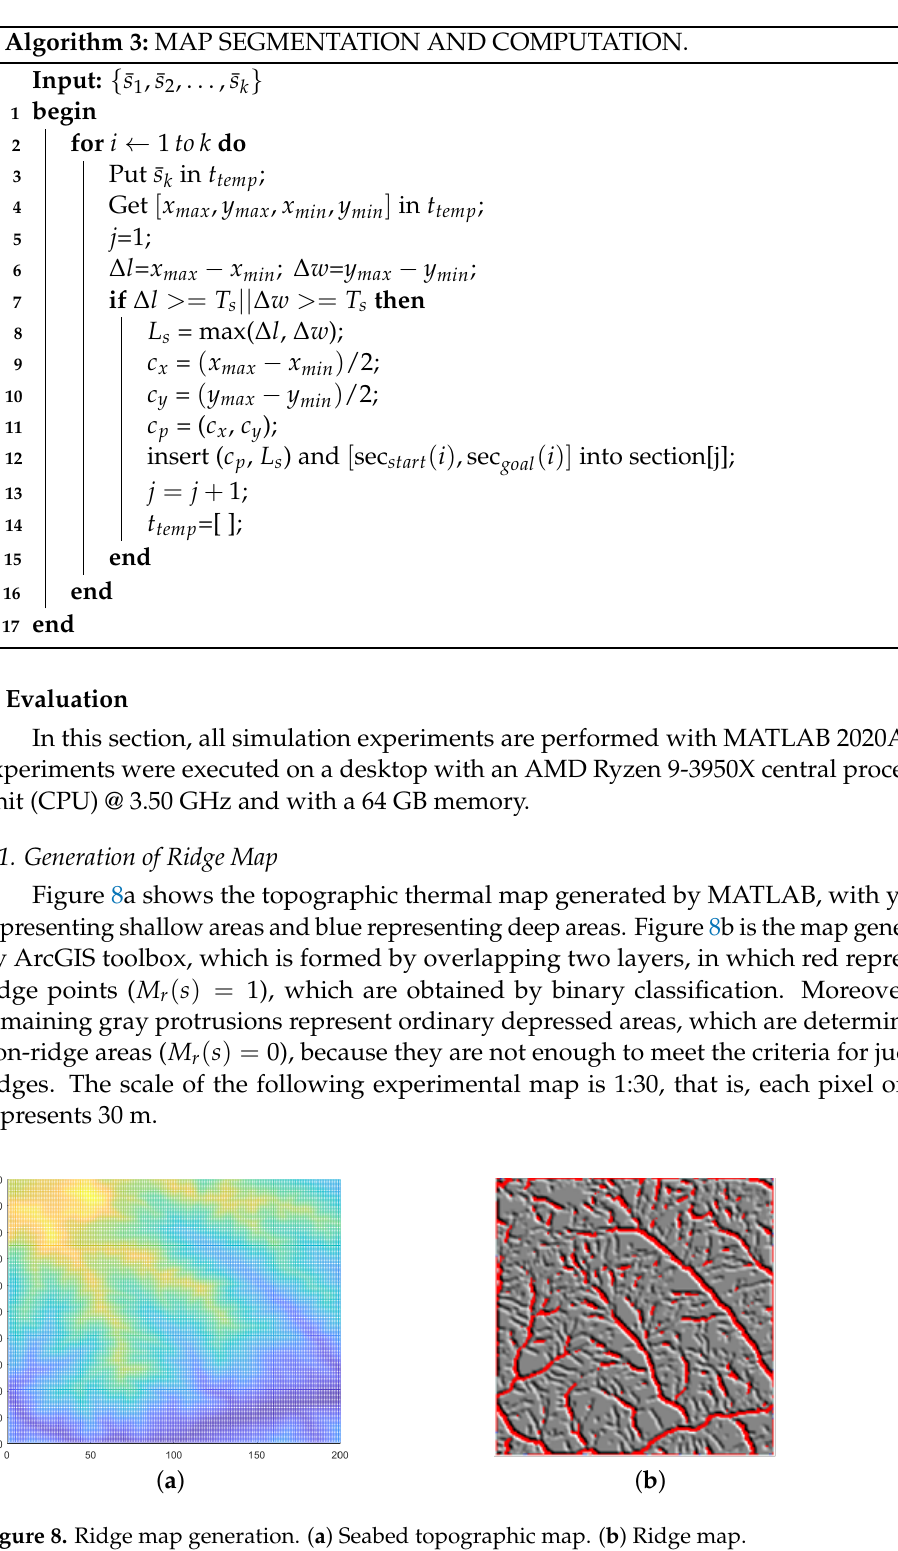
Figure 8. Ridge map generation. ( a ) Seabed topographic map. ( b ) Ridge